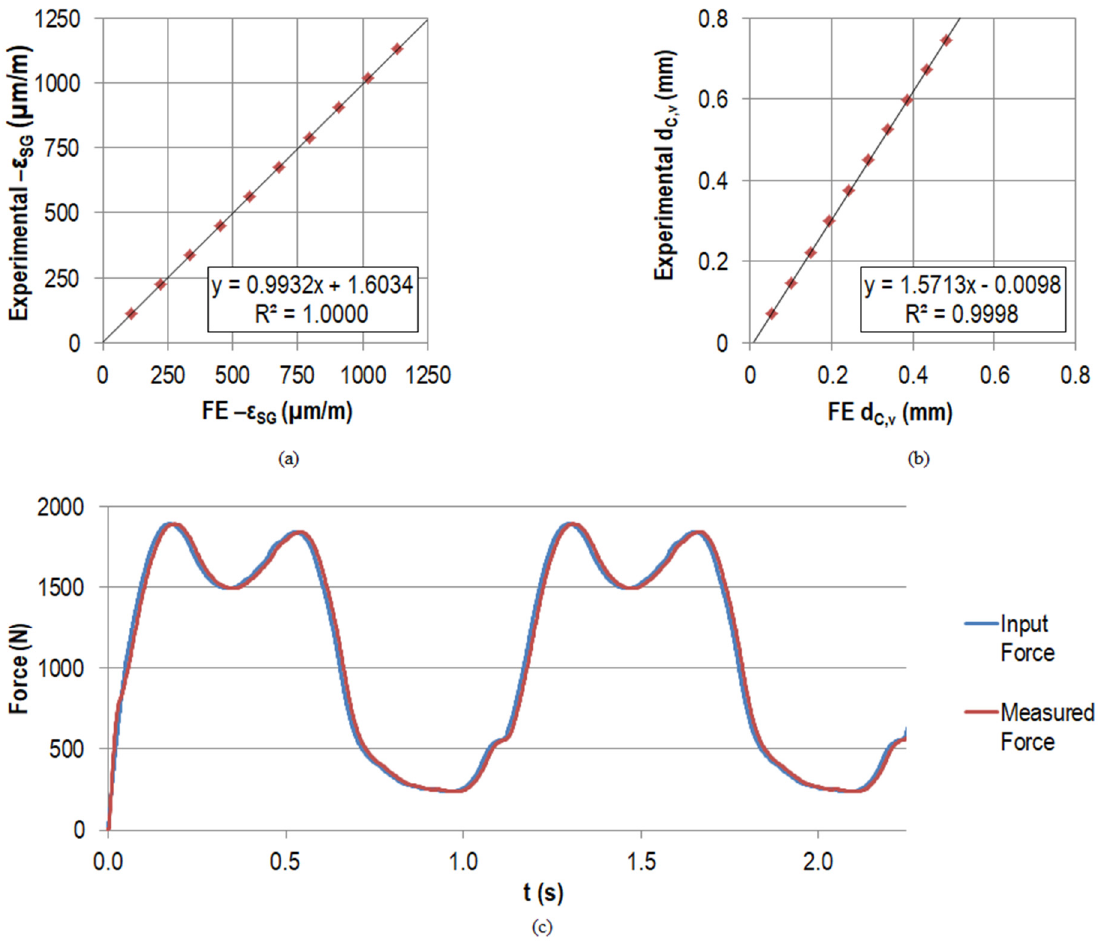
Figure 7. Linear regression results between FE data and experimental measurements of the strain gauge strain ε SG ( µ m/m) in ( a ) and of the displacement of point C in vertical direction d C,v (mm) in ( b ) when applying the maximal force of the gait cycle step-wise in 10 increments. All the measured and simulated strains were of compressive nature (negative strain value); for convenience, the axes show − ε SG . In ( c ), the force input and the measured force by the load cell are displayed for the first two load cycles (N).